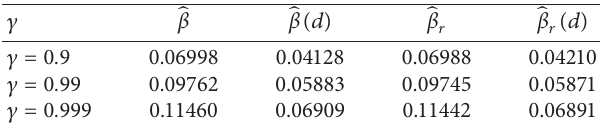
Table 3: The estimated MSE of the estimators when n � 100.